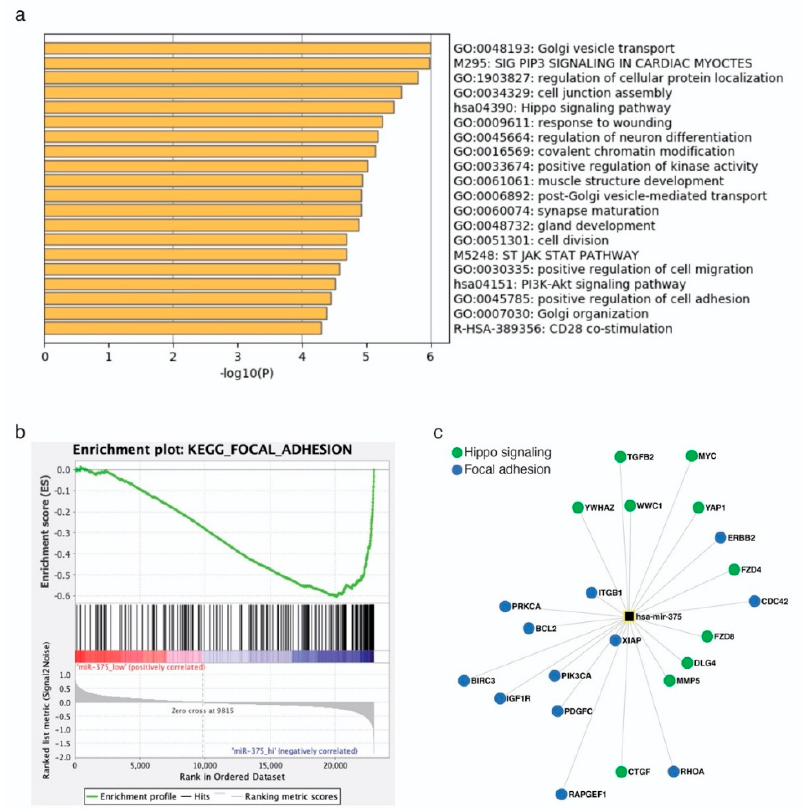
Figure 3. miR-375 target genes are involved in Hippo and epithelial to mesenchymal transition (EMT) signaling pathways in MCC cells. ( a ) Gene ontology analysis was performed in Metascape using the top 500 predicted miR-375 target genes. ( b ) Gene set enrichment analysis was performed using previously published transcriptome microarray data of MCC cell lines with high (WaGa and MKL1) and low (MCC13 and MCC26) miR-375 expression. Enrichment plot of the kegg_focal_adhesion signaling pathway is depicted. ( c ) miR-375 target genes involved in Hippo and focal adhesion signaling pathways.